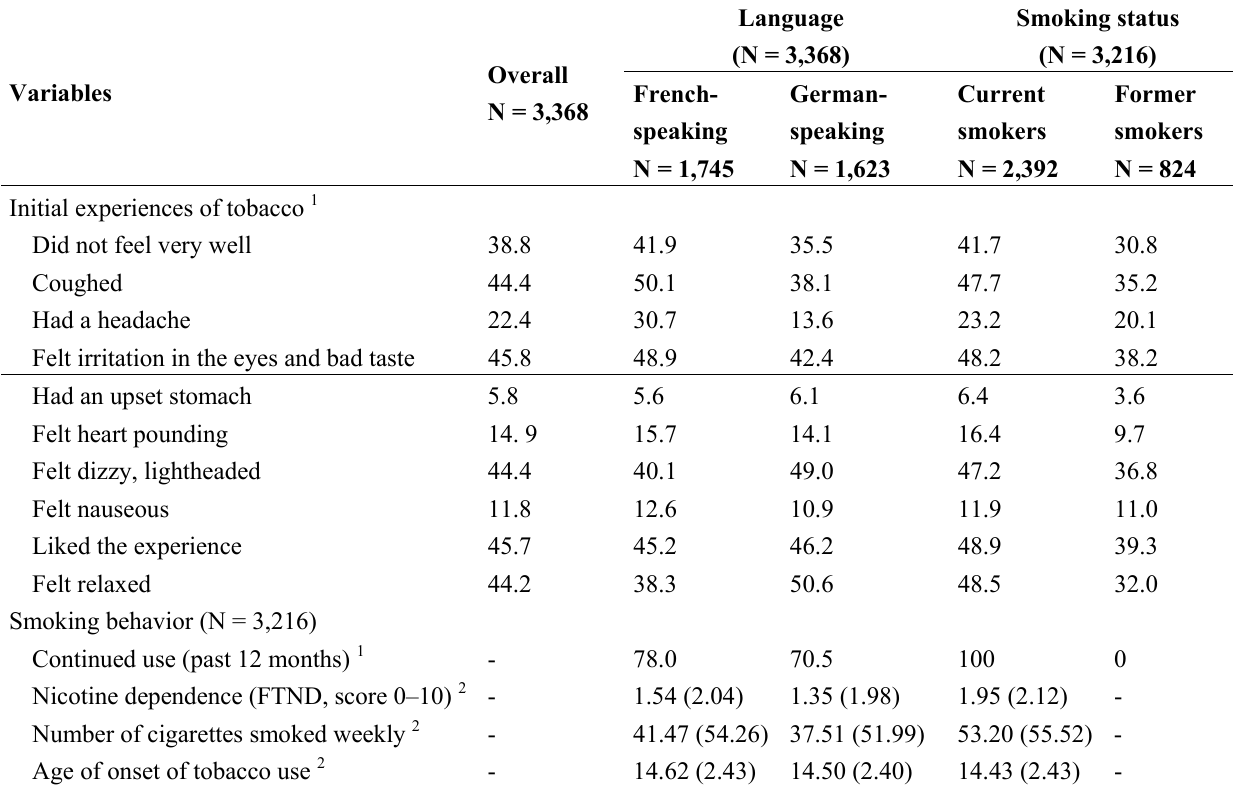
Table 1. Descriptive statistics for initial experiences of tobacco and smoking